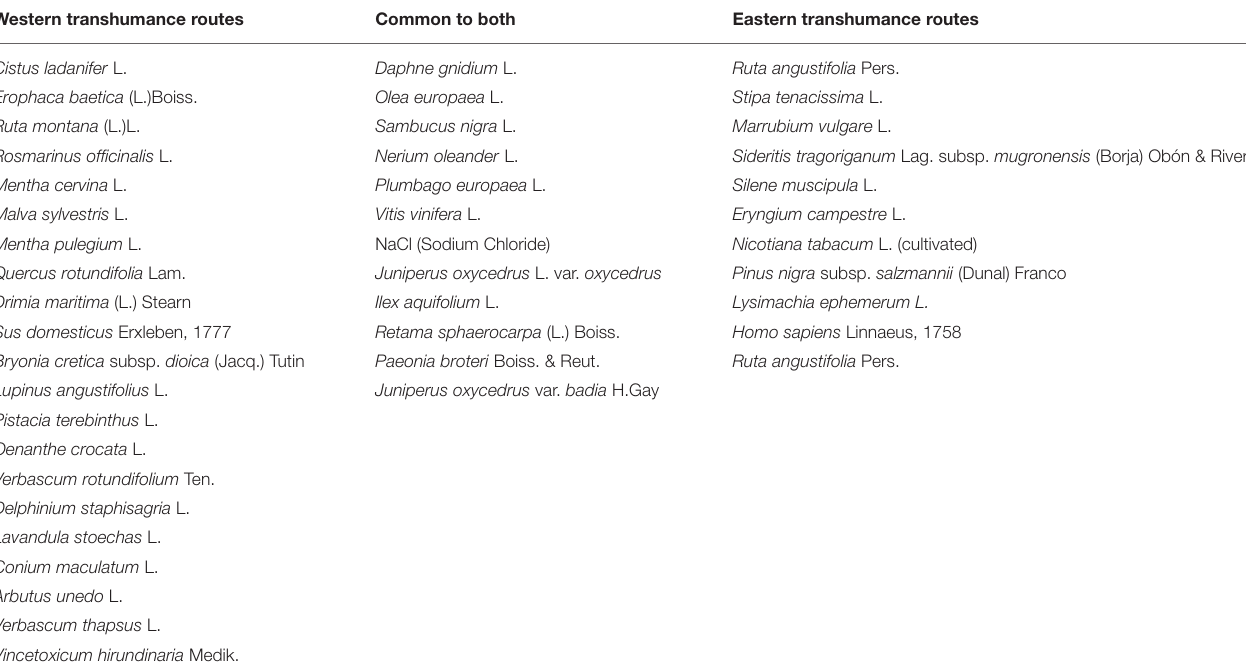
TABLE 5 | Different ingredients for the main groups of